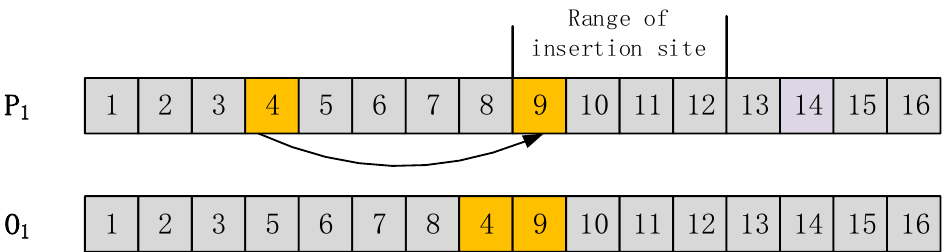
Figure 5. Sequence substring crossing.